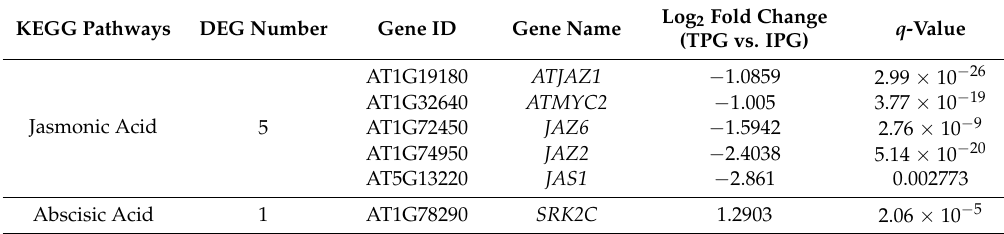
Table 3. List of the DEGs involved in two KEGG pathways related to the phytohormon